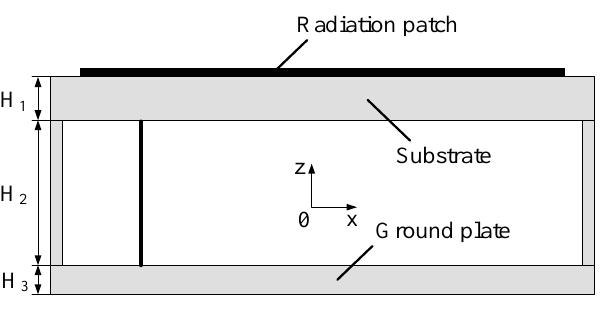
Figure 2. Patch antenna with an air layer structure.